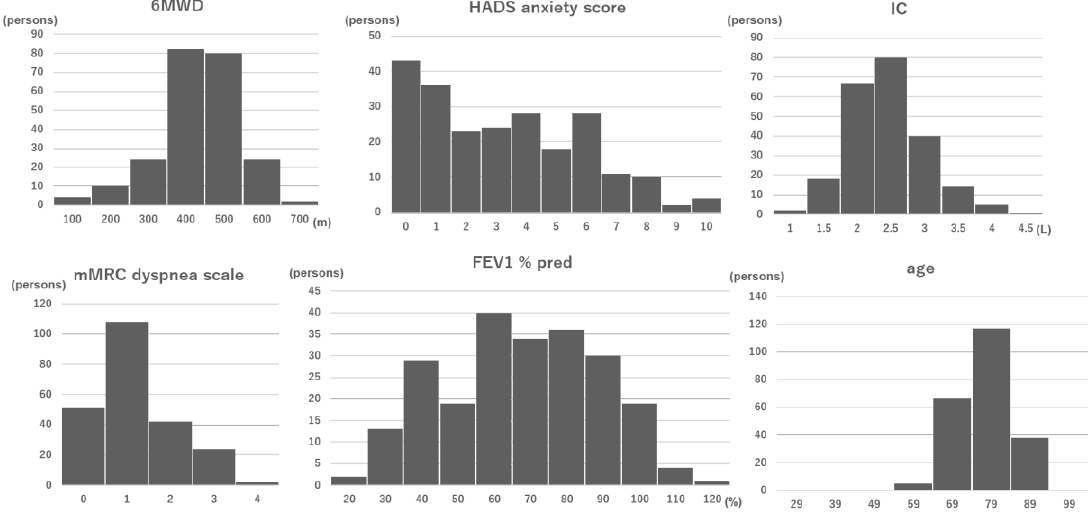
Figure 2. Histograms of the indicators. Abbreviations: 6MWD, 6 min walking distance; HADS, Hospital Anxiety and Depression Scale; IC, inspiratory capacity; mMRC, modified British Medical Research Council; FEV1 %pred, forced expiratory volume in one second % of predicted .